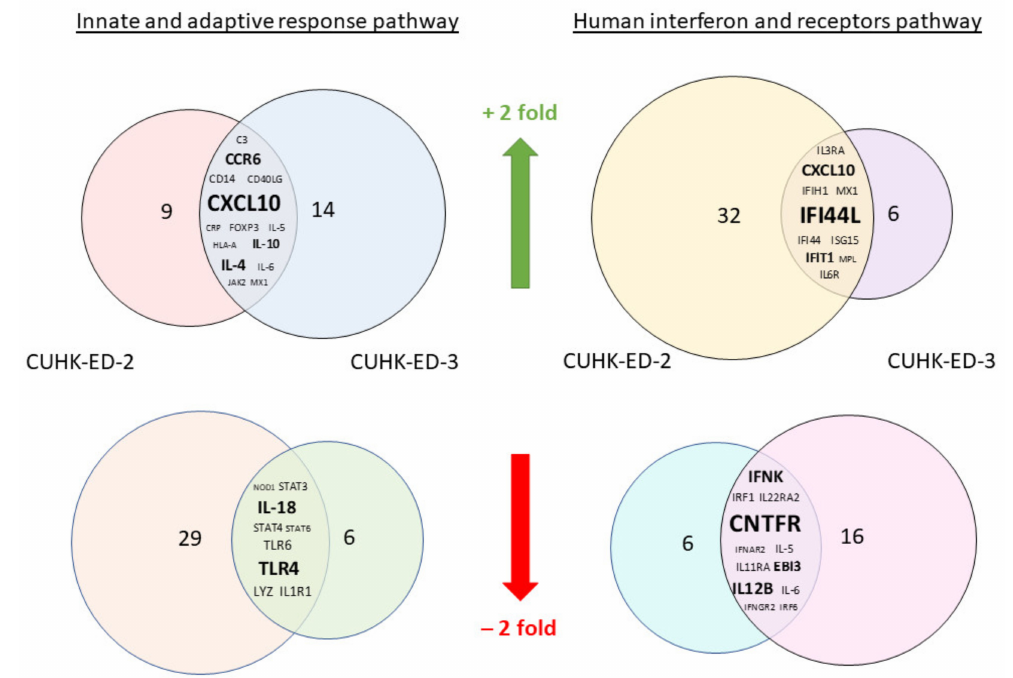
Figure 4. A Venn diagram showing genes that were either mutually upregulated or downregulated between CUHK- ED-2 and CUHK-ED-3 in the two selected pathways: the mutually upregulated and downregulated genes are listed in the overlapped area between the two circles. The font size of the genes is relatively proportional to the fold change of gene